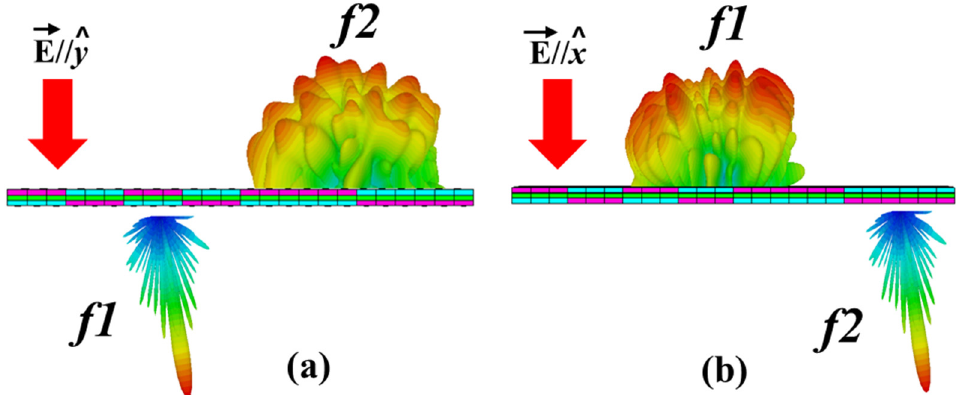
Figure 1. Conceptual illustration of the proposed metasurface for ( a ) the y -polarized wave ( b ) the x -polarized wave.